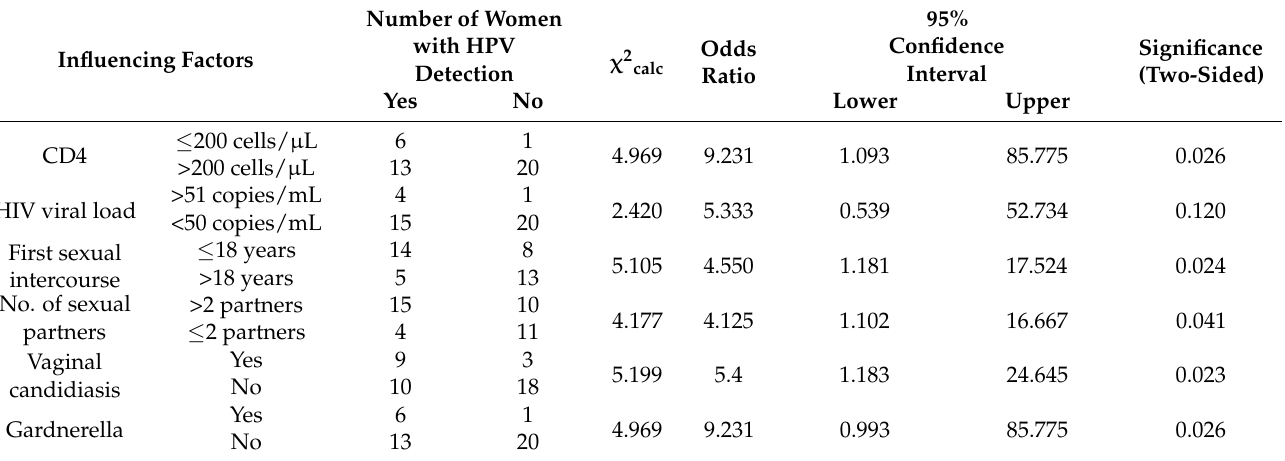
Table 1. Summary of factors correlated with detection of HR-HPV